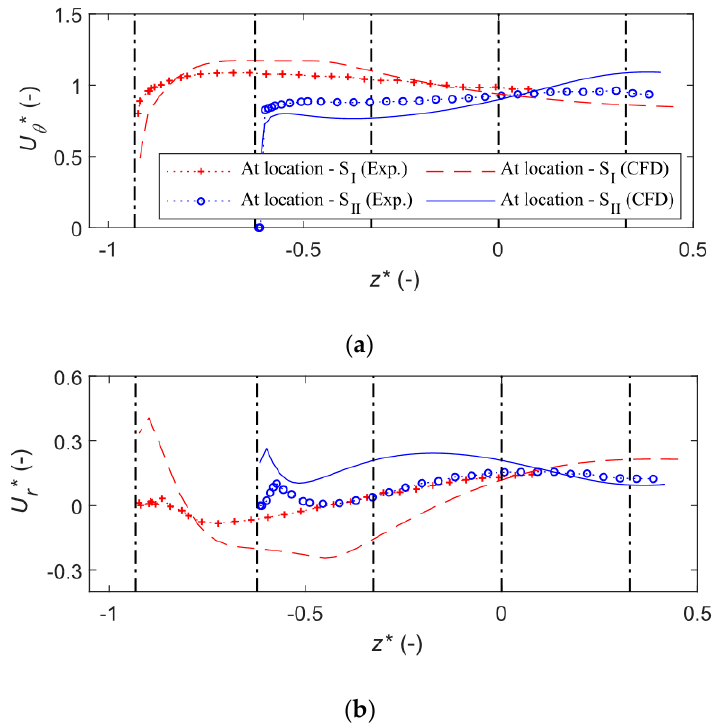
Figure 6. ( a ) Normalized tangential velocity ( U ∗ θ ); ( b ) radial velocity ( U ∗ r ) at the spiral casing (SC) measurement locations: S I and S II . The velocities are scaled by the bulk velocity U b . The measurement locations can be found in Figure 1b. z* is the dimensionless vertical distance in the spiral casing. The experimental data are from Mulu and Cervantes [27]. The dashed-dotted vertical lines represent, from left to right: the bottom of the SC at S I , the bottom wall of the SC at S II , the lower level of the leading of the stay vanes (SVs) / guide vanes (GVs), the mid-span of the GVs, and the upper level of the leading edge of the SVs / GVs.